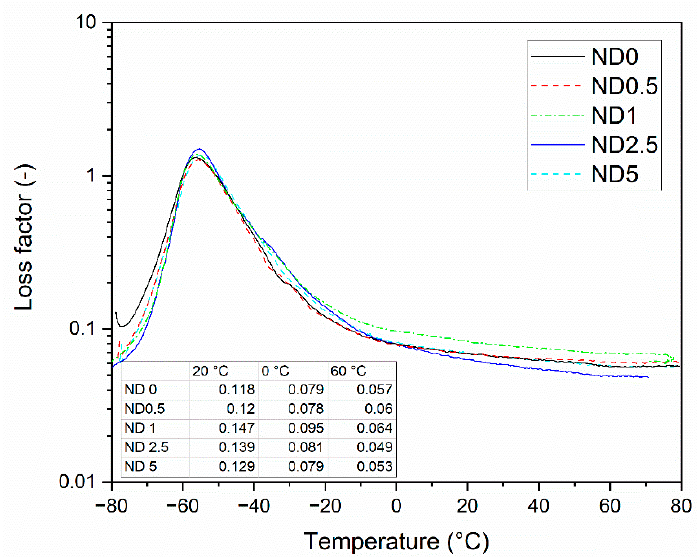
Figure 6. The loss factor of the rubber compounds as a function of temperature.